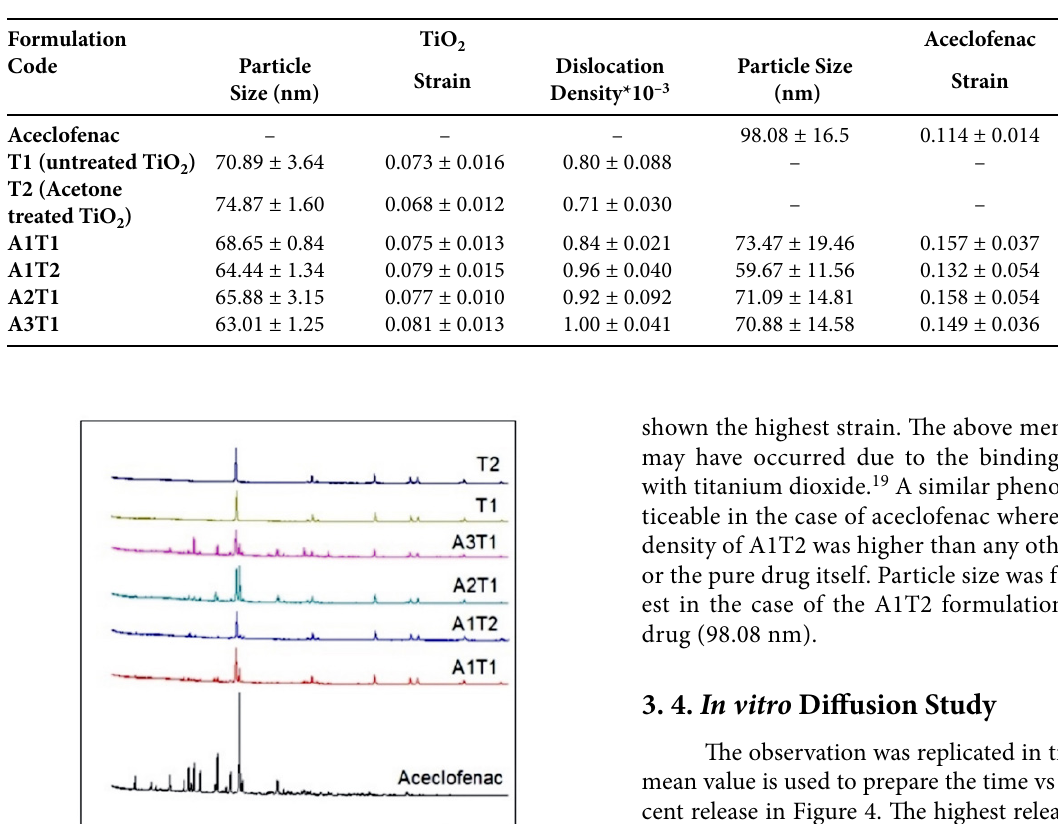
Table 2. Solid state particle properties of aceclofenac-titanium dioxide kneaded products